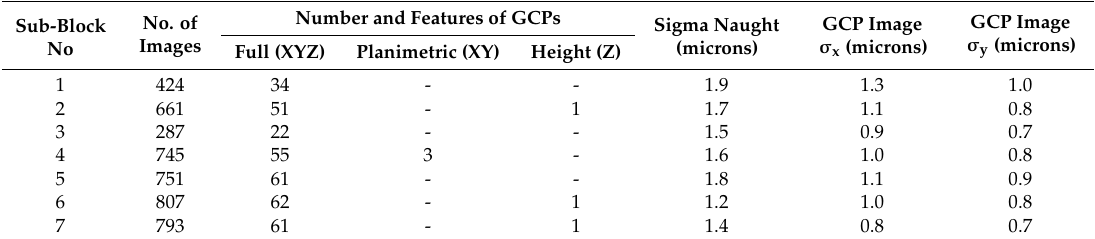
Table 1. Photogrammetric block properties and triangulation results.